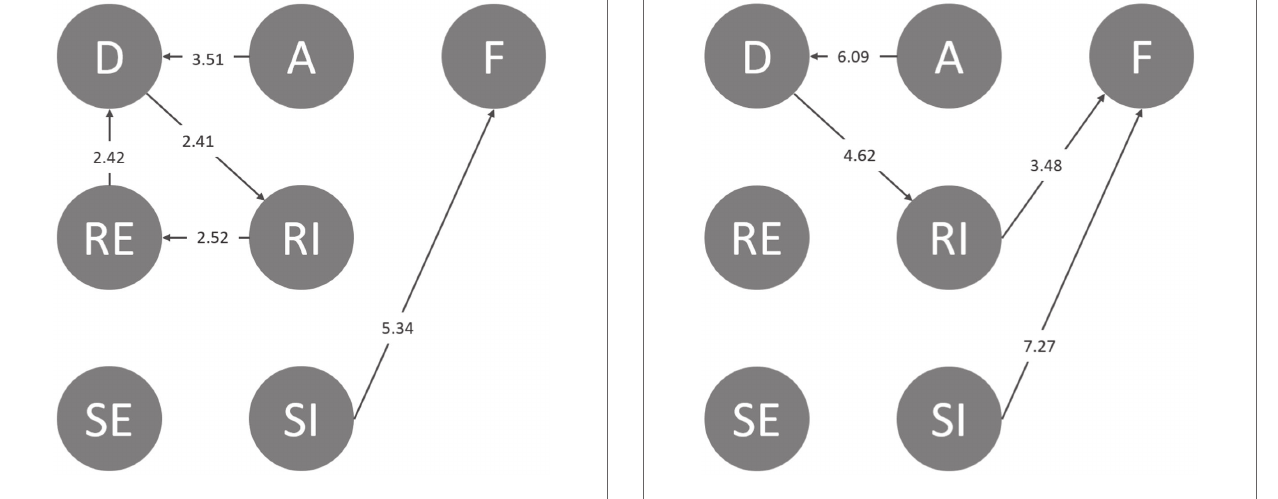
FIGURE 7 | Behavioral transition diagram of conscientiousness.